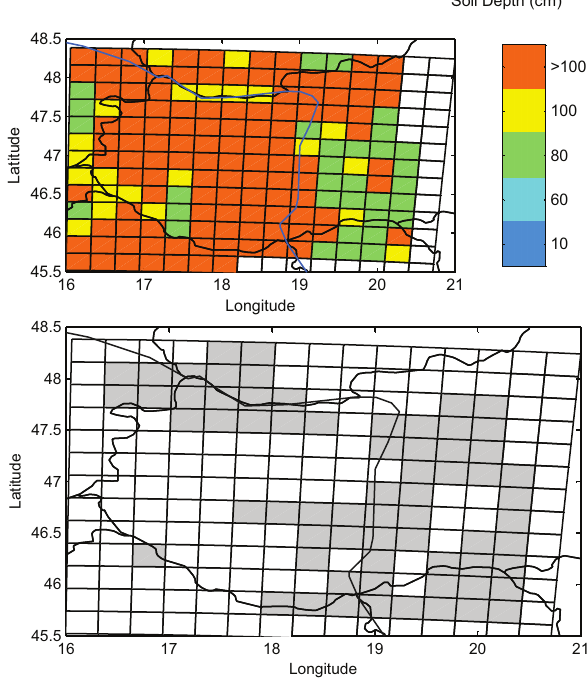
Fig. 14. (a) Soil depth classes and (b) groundwater affected soils (dark cells) occurring in the test region, as based on FAO soil classification and expected rooting depth being aggregated to the spatial resolution of 0.25 ◦